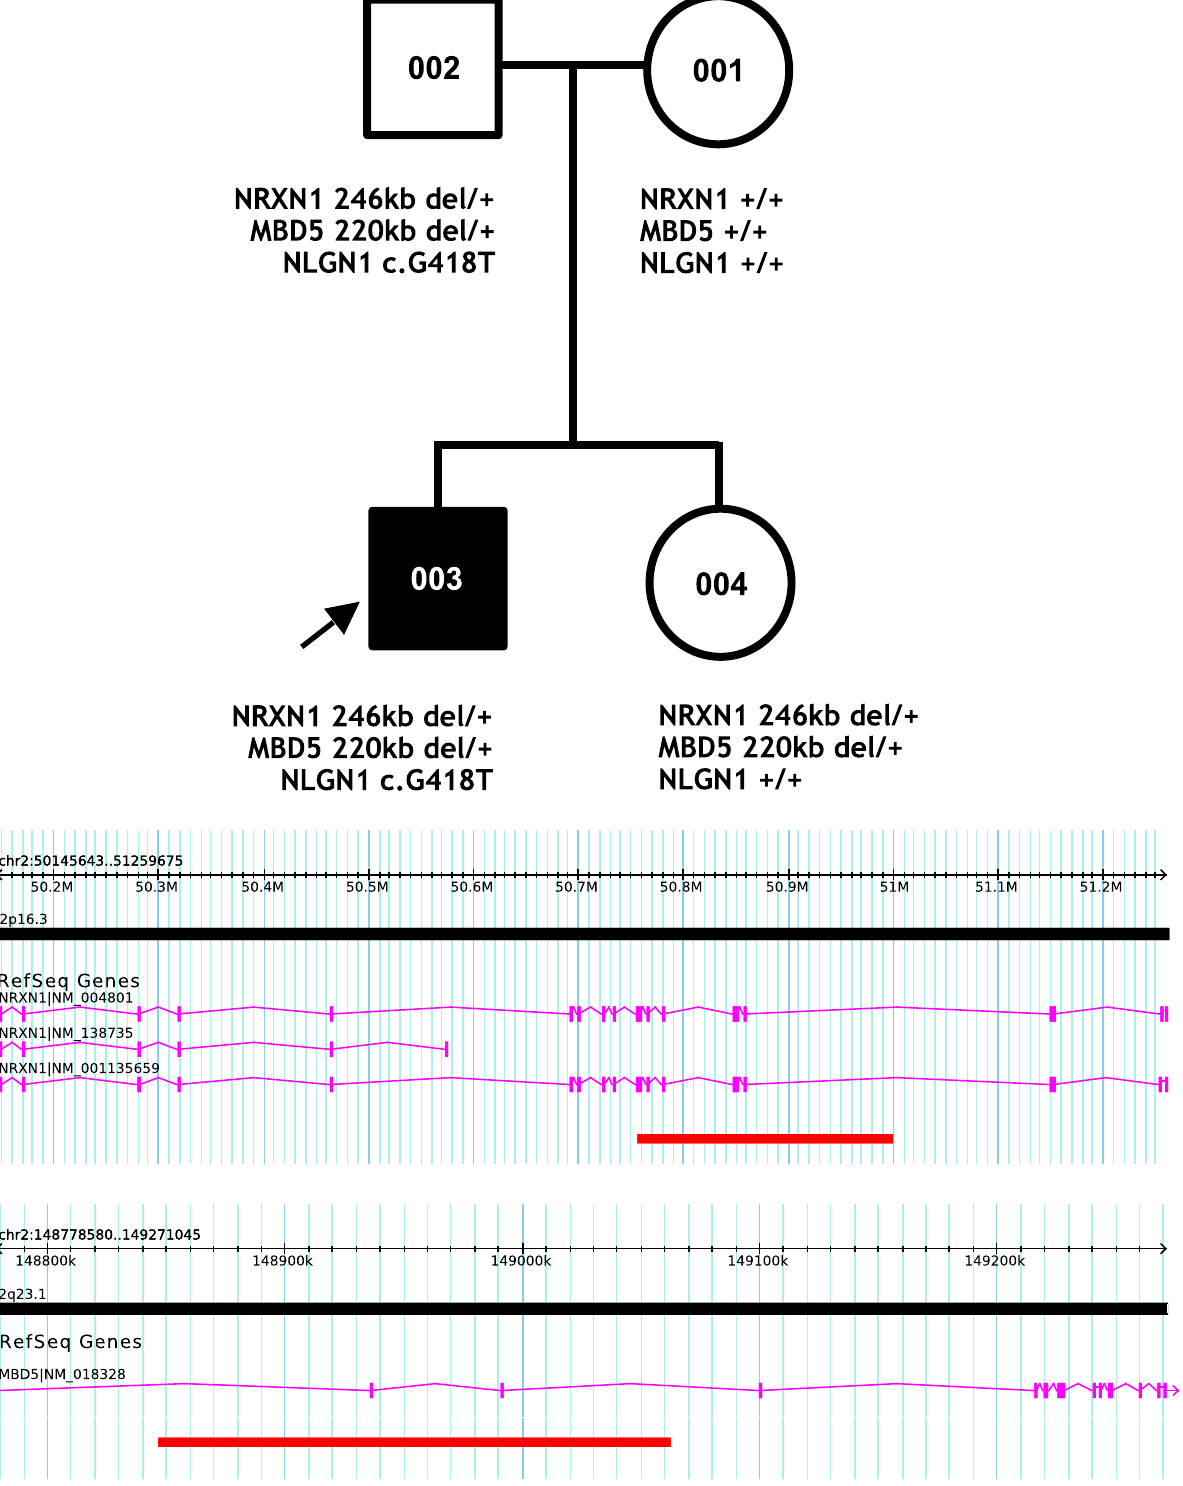
Fig. 1 Pedigree with microarray results and annotated NRXN1 ( a ) and MBD5 ( b )